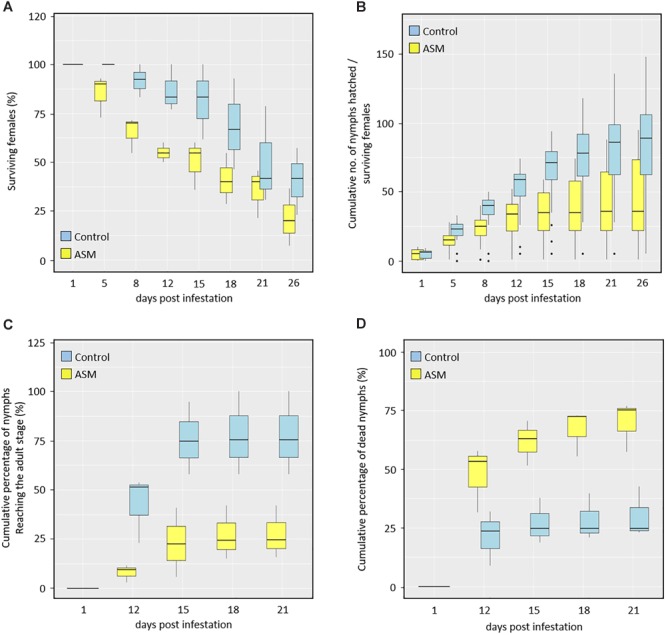
Effect of ASM treatments on Dysaphis plantaginea fundatrigeniae life traits on apple. ASM or control was applied three times (at 16, 9, 2 dbi) before infestation with one (A,B) or two/three (C,D) mature females per apple scion. Box plots representing (A) longevity of surviving females on a total of 39 plants for control and 35 for ASM treatment, (B) cumulative number of nymphs produced per surviving females produced on the same plants as in (A). (C,D) Box plots representing larval evolution of nymphs produced from two females deposited per control-treated plant (n = 39 plants) and from three females deposited per ASM-treated plant (n = 37 plants): (C) cumulative percentage of nymphs evolving over time into adult individuals and (D) cumulative percentage of nymphs dying over time. The box plot shows the median (horizontal line), the second and third quartile (box), the first and fourth quartile (whisker) as well as outlier data (dots).